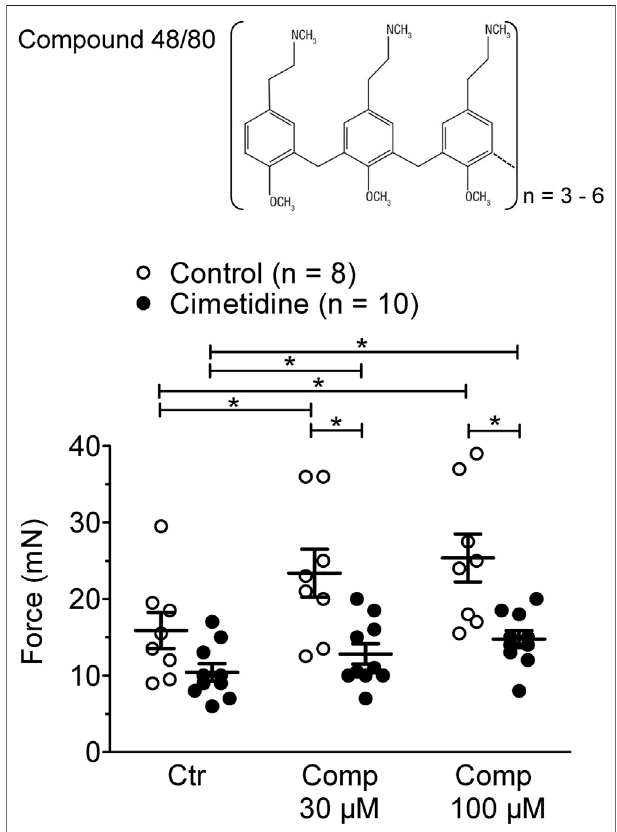
FIGURE4| Effectofcompound48/80alone(Comp30or100 μ M,open bars) or in the presence of 10 µM cimetidine (closed bars) on FOC of isolated electricallydriven(1 Hz)leftatriumofH 2 -receptoroverexpressingH 2 -TGmice. Numbers in bars indicate the number of animals studied. * p < 0.05 vs. Ctr (no drug addition); § p < 0.05 vs. absence of compound 48/80.